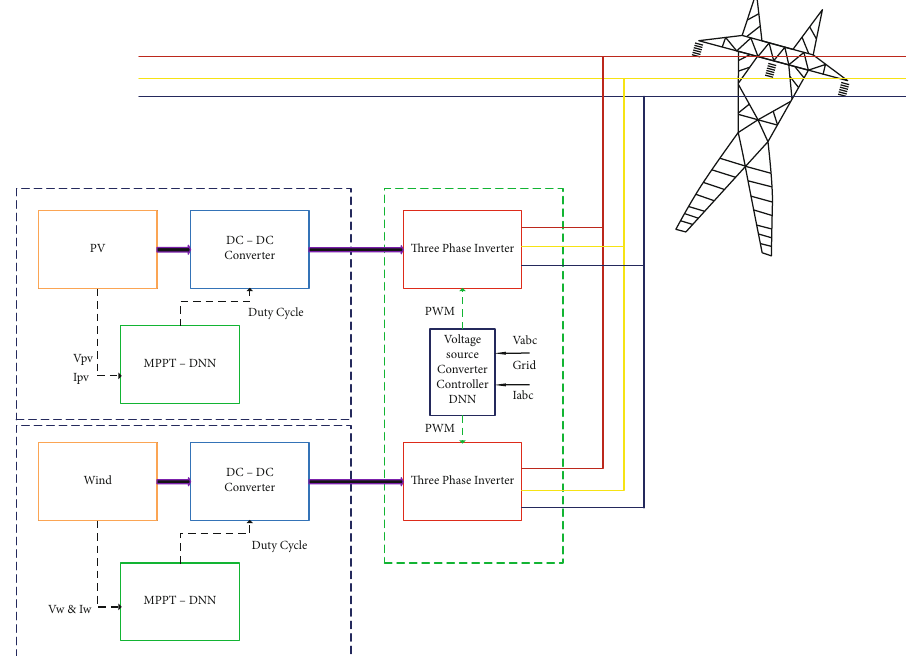
Figure 1: Block diagram of the proposed microgrid system and its controller.